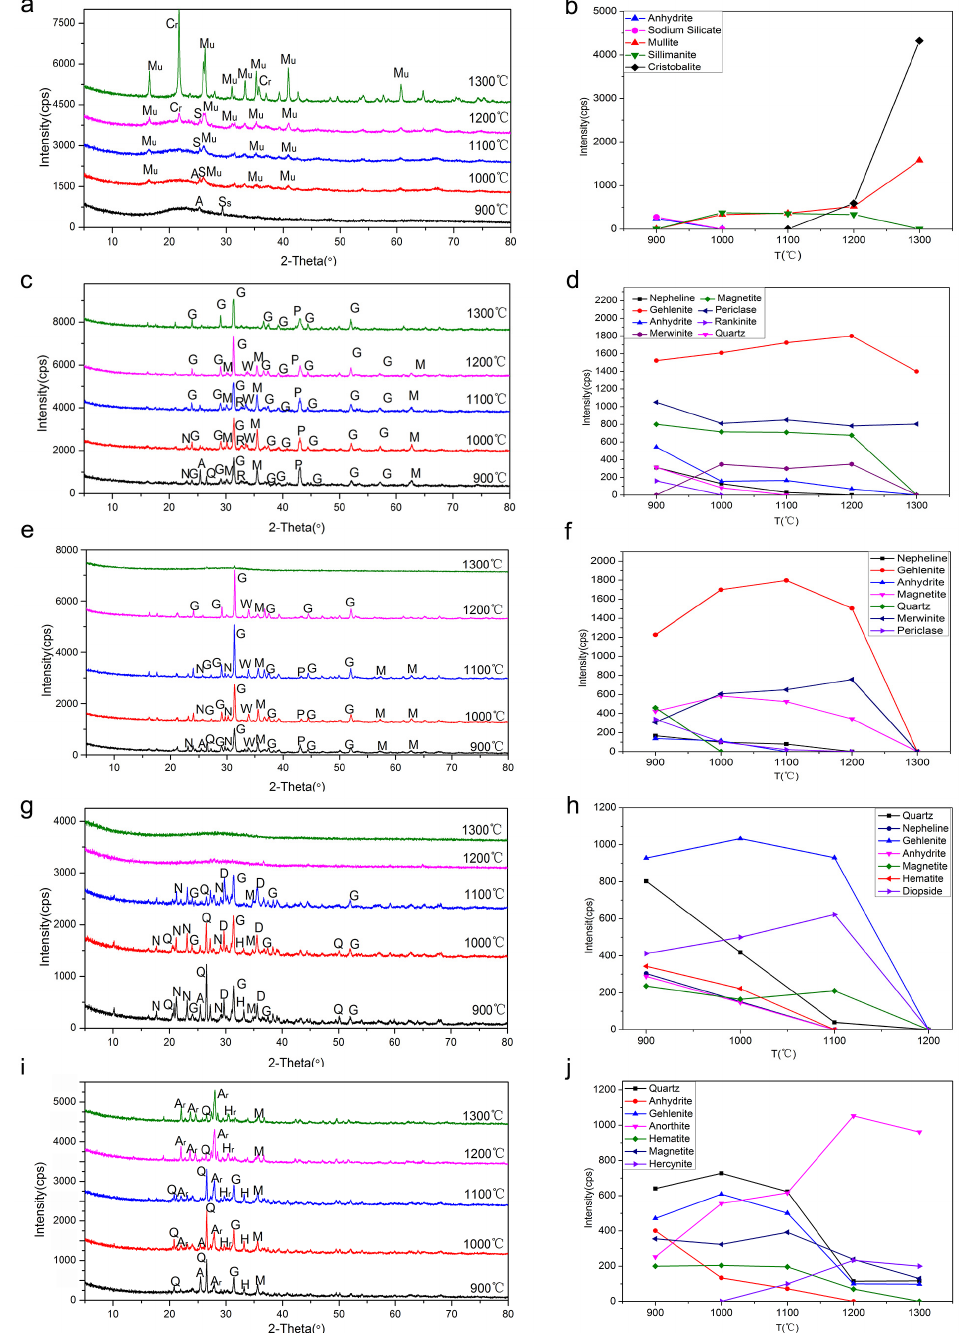
Figure 3. X-ray diffraction (XRD) patterns and intensity-temperature curves at different temperatures: ( a ) and ( b ), G100; ( c ) and ( d ), D100; ( e ) and ( f ), G10D90; ( g ) and ( h ), G30D70; and ( i ) and ( j ), G50D50. A, anhydrite; Ss, sodium silicate; Mu, mullite; S, sillimanite; Cr, cristobalite; G, gehlenite; N, nepheline; Q, quartz; P, periclase; R, rankinite; M, magnetite; W, merwinite; H, hematite; D, diopside; Hr, hercynite; Ar, anorthite and Hr,